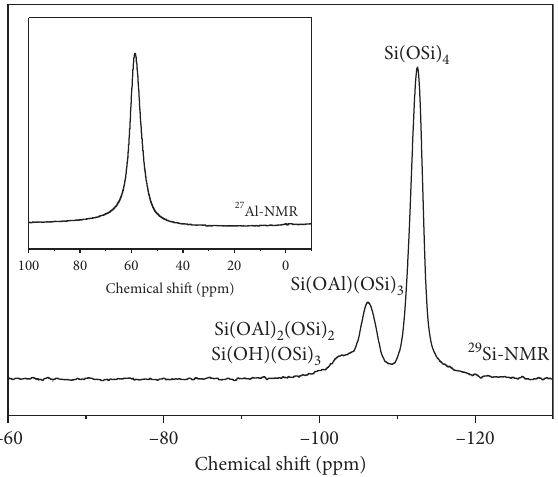
Figure 4: 29 Si single pulse and 27 Al NMR of calcined CHA zeolite (Si/Al � 10.8, sample